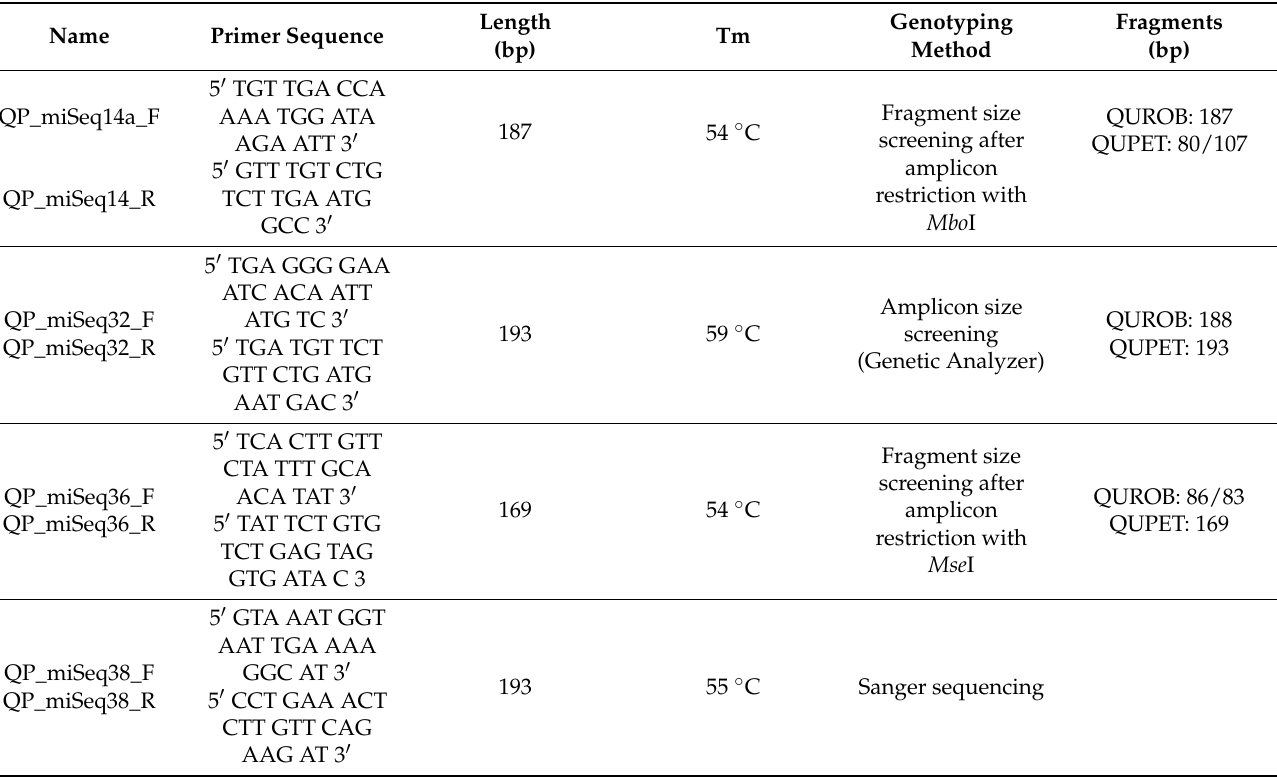
Table 1. Sequences and characteristics of selected primers.